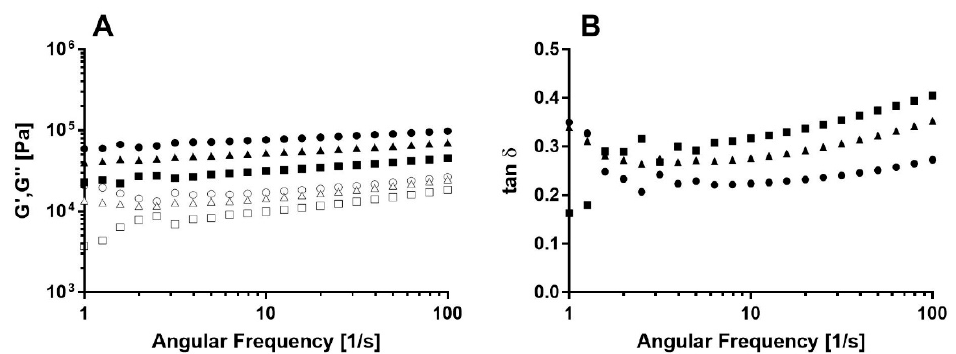
Figure 4. Typical ( A ) frequency sweep curves representing the storage modulus (G’, closed symbols) and loss modulus (G’’, open symbols) of various bigel samples for H1 ( ● , о ), H2 ( ▲ , ∆ ) and H6 (squares) bigel samples, HLB2, and HLB6 ( ■ , □ ). ( B ) the corresponded calculated tan δ for H1 ( ● ), H2 ( ▲ ) and H6 (squares) bigel samples, HLB2, and HLB6 ( ■ ) .